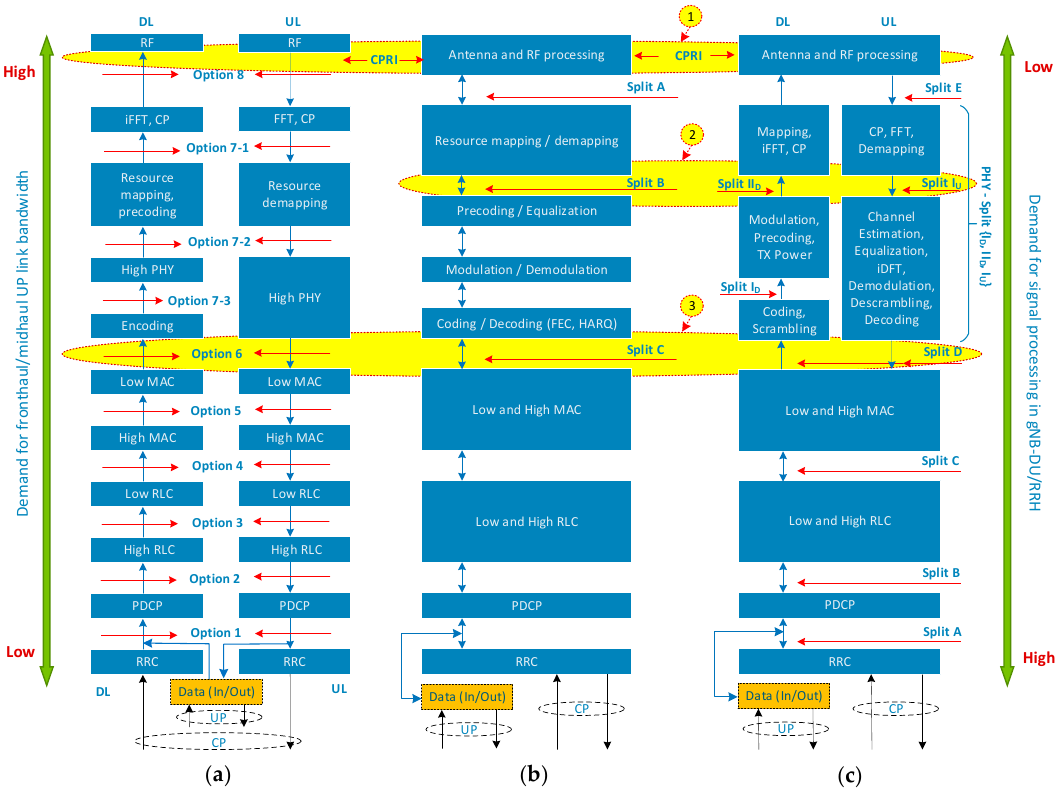
Figure 7. Models of Splits / Options and functions performed by 5G-FH / MH components in the scope of F1 / F2 interfaces in the NG-RAN domain: ( a ) functional division according to 3GPP [46], ( b ) functional division according to 5GPPP [1], ( c ) functional division according to CPRI Industry Forum—interface eCPRI v.2.0 [32].